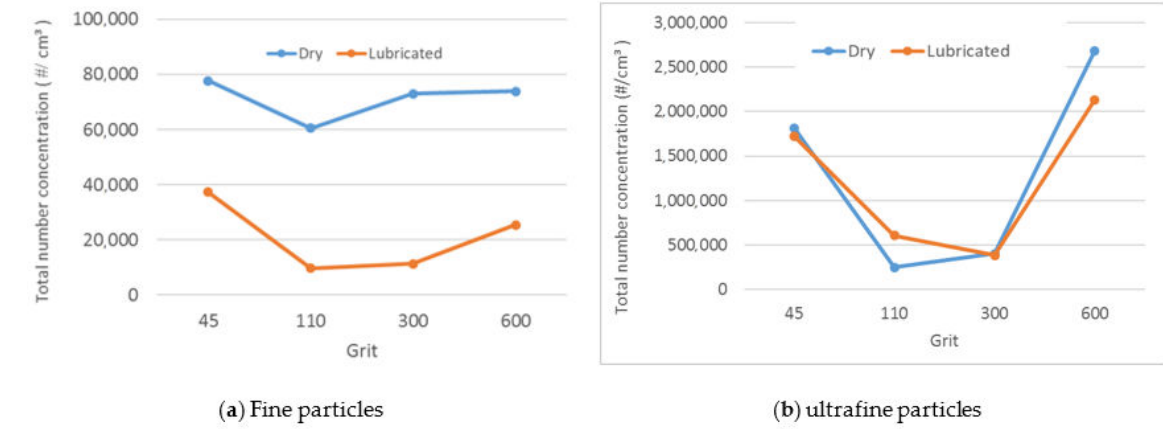
Figure 18. Total number concentration of particles while grinding white granite under dry and lubricated conditions: ( a ) FP, ( b ) UFP (Vs = 3500 rpm, f = 1000 mm/min, grit 600).